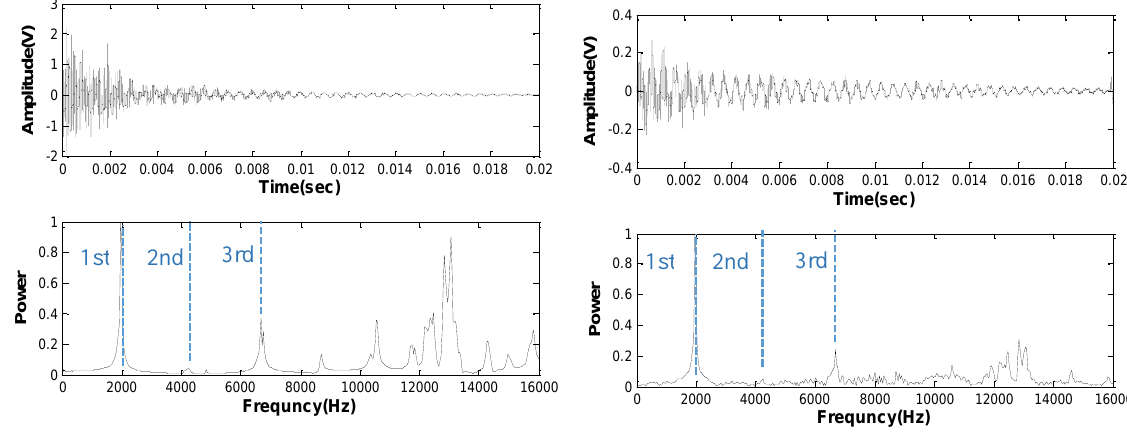
Figure 8. Time ( top set ) and normalized frequency power ( bottom set ) signals obtained from vibration tests on concrete prism. Signals for a MEMS sensor ( right set ) compared to those from a contact accelerometer ( left set ). Expected vibrational mode frequencies indicated by dashed lines (1.96, 4.08 and 6.5